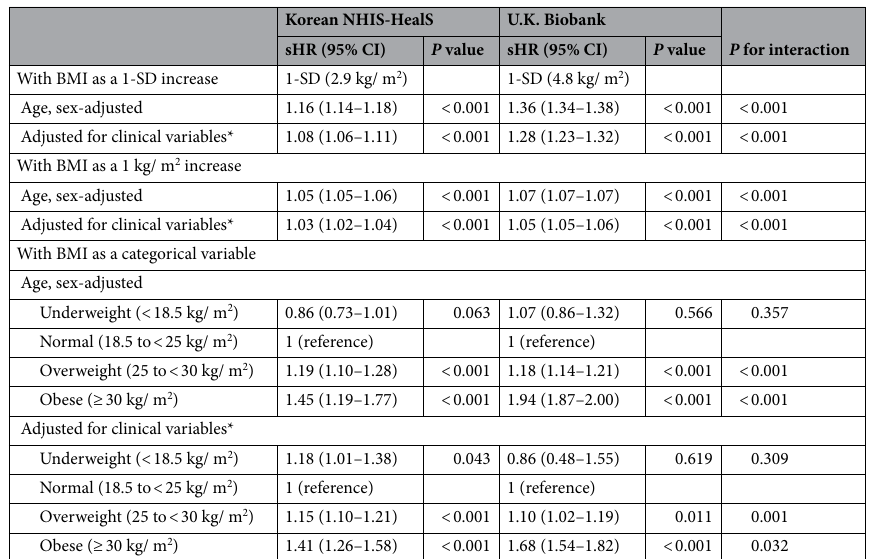
Table 3. AF risk of BMI according to the age-, sex-, and clinical variable–adjusted model with competing risk of death in the total population. NHIS-HealS National Health Insurance Service’s Health Screening, sHR subdistribution hazard ratio. *Adjusted for age, sex, and clinical variables including smoking, alcohol use, heart failure, hypertension, diabetes mellitus, ischemic stroke or transient ischemic attack, previous myocardial infarction, hyperthyroidism, hypothyroidism, osteoporosis, dyslipidemia, end stage renal disease or chronic kidney disease, chronic obstructive pulmonary disorder, history liver disease, and history malignant